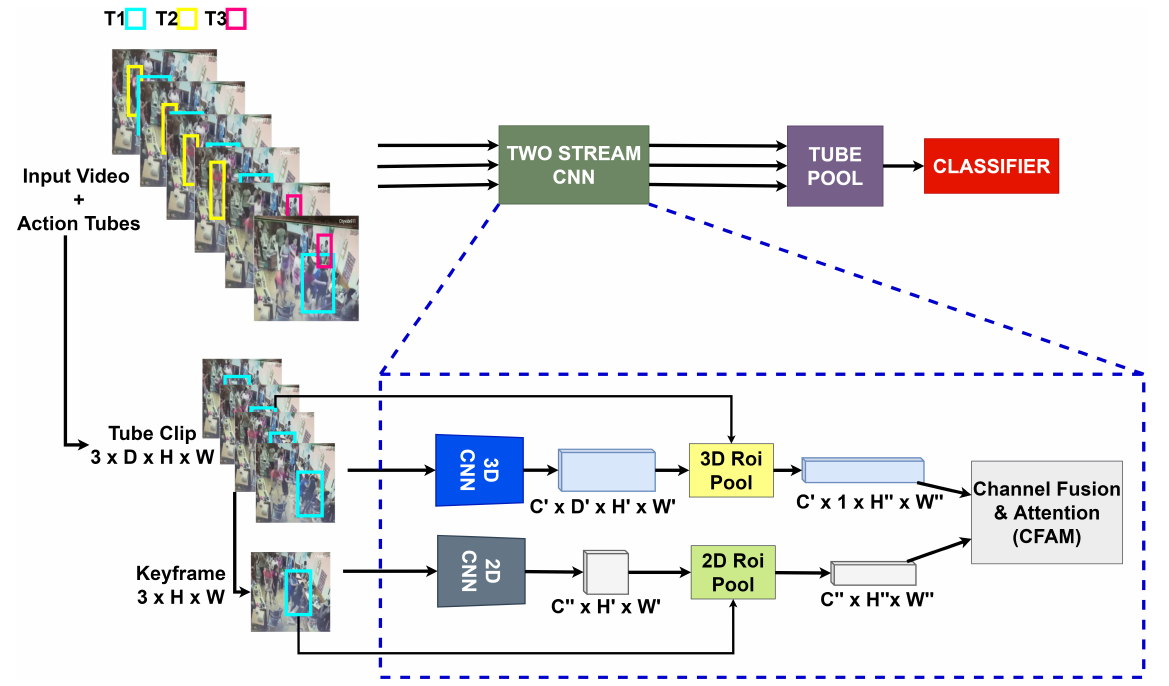
Figure 6. The proposed model is composed of two (3D-CNN + 2D-CNN) streams. After building action tubes ( T 1, T 2 and T 3), each tube clip is passed through the two-stream model. The dashed box shows the internal structure of the model. In the spatiotemporal branch, the tube clip is passed through the I3D, and the central tube box is projected to the output feature map. In the spatial branch, the keyframe of the tube clip is passed through a 2D-CNN, and the frame box is projected to the output feature map. Both branches are fused in the CFAM module. The fused feature maps of the two-stream model are pooled (using max pooling) to merge the feature maps into one. Finally, the pooled feature map is passed to the classifier